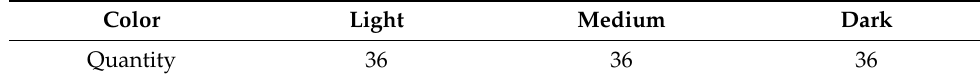
Table 2. Distribution of the initial